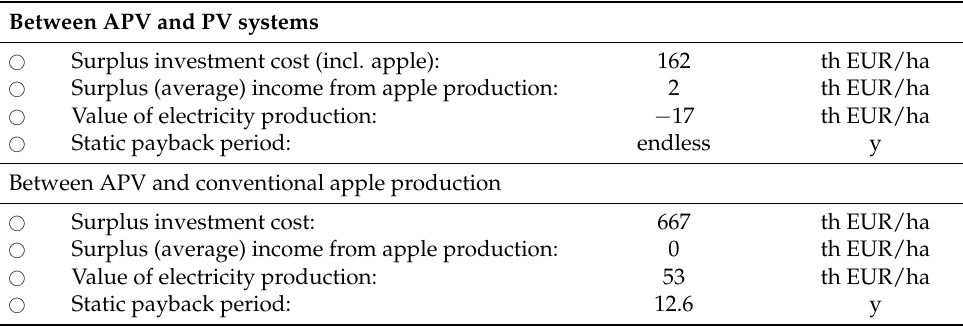
Table 3. Comparison of the economic differences of the baseline scenario. Between APV and PV